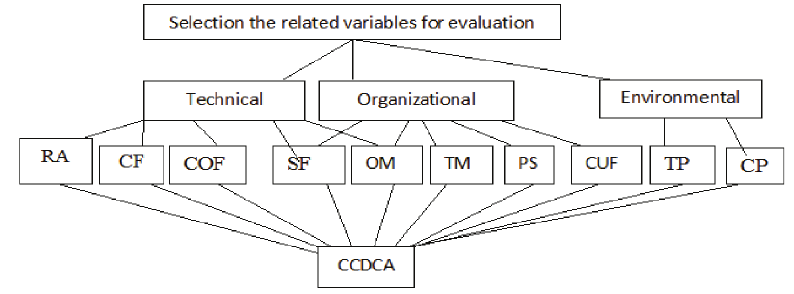
Fig.9. The hierarchy to CSF evaluation of cloud base data center adoption